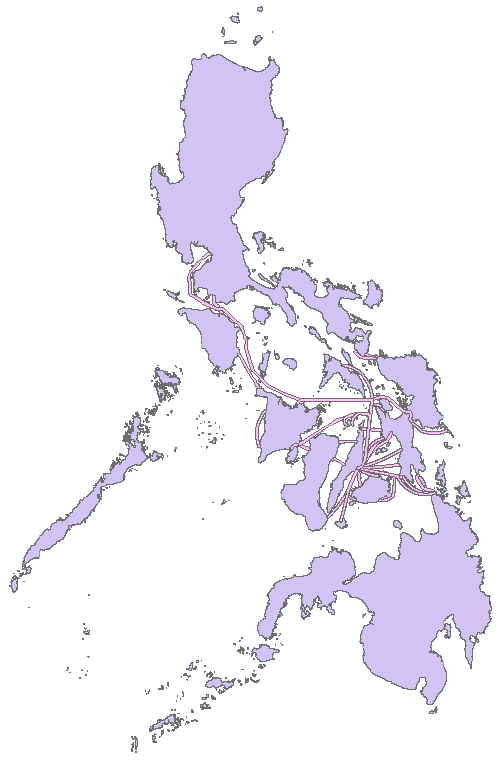
Figure 4. Local ferry routes.